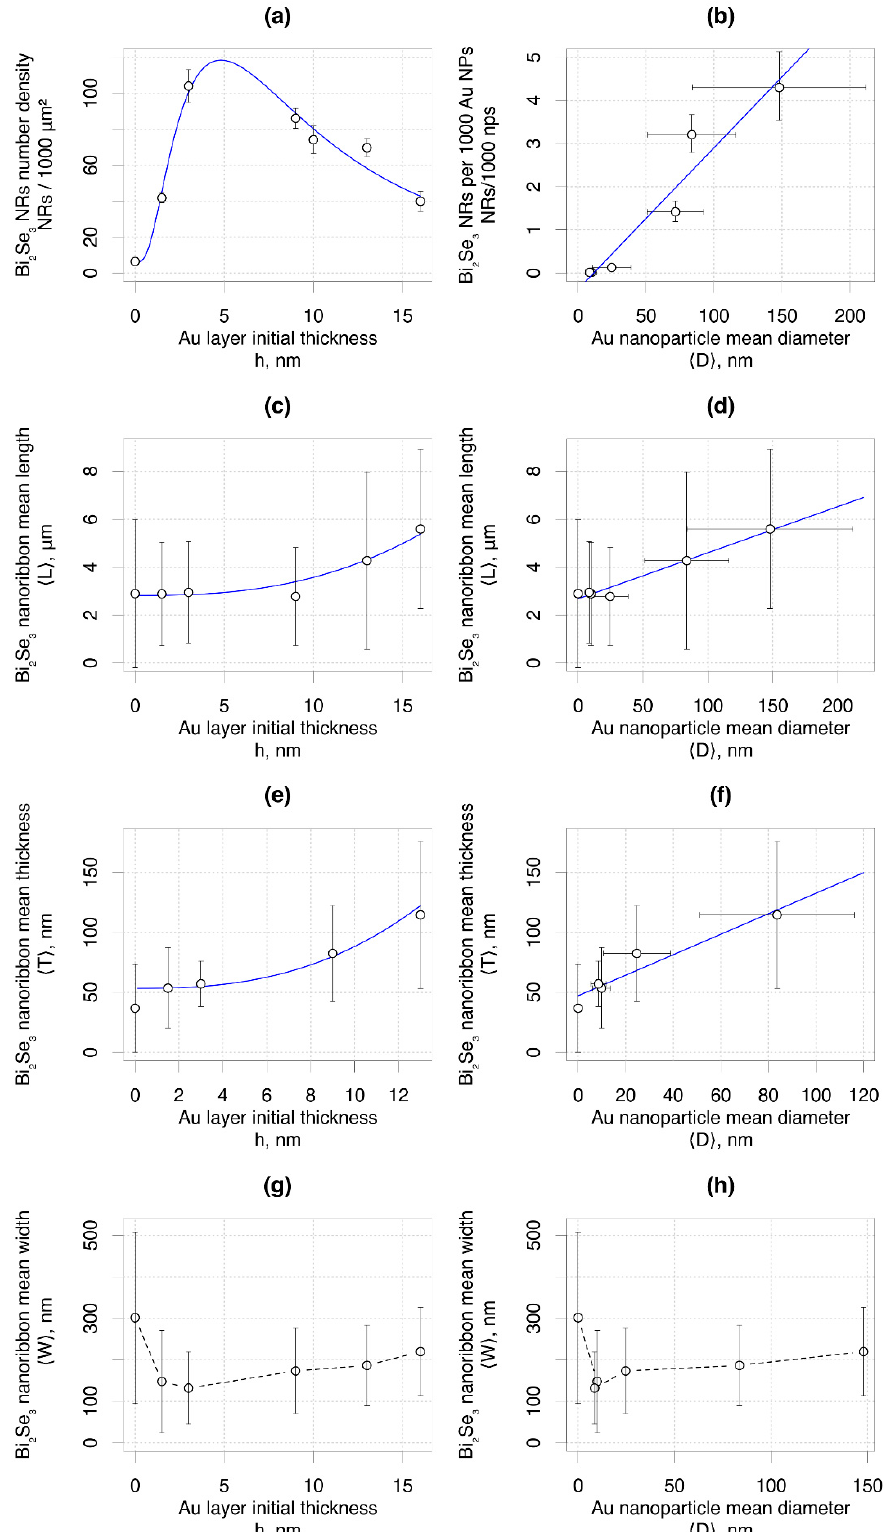
Figure 3. Various Bi 2 Se 3 nanoribbon parameters as a function of initial Au layer thickness: ( a , c , e , g ) and Au nanoparticle mean diameter ( b , d , f , h ). The blue lines are guides to the